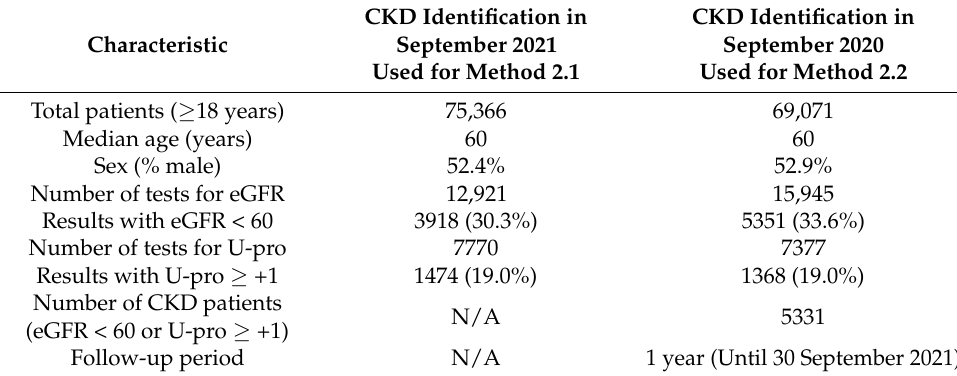
Table 1. Descriptive statistics of the study